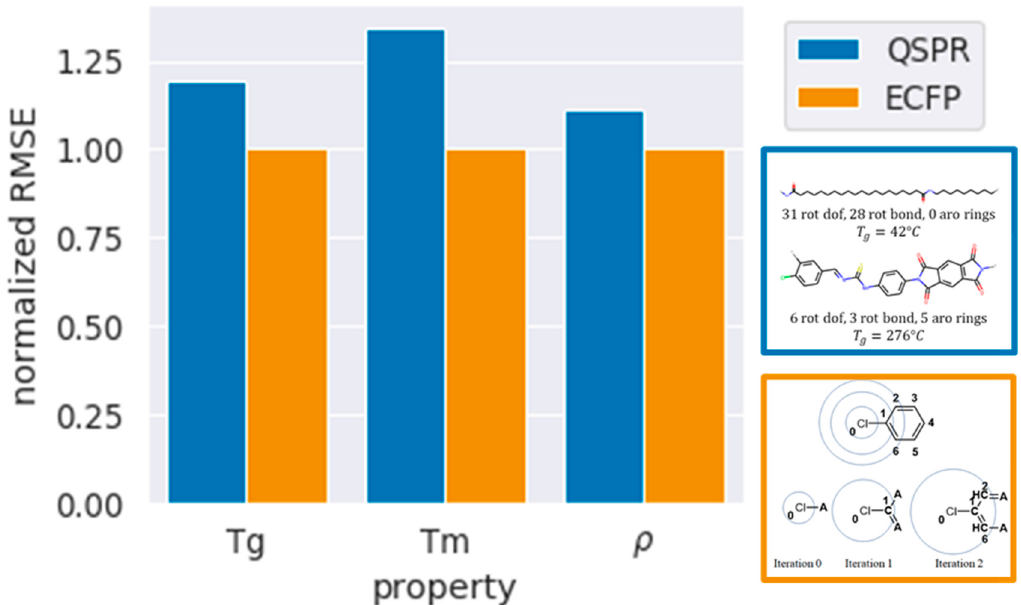
Figure 6. Summary of the best models using each fingerprinting technique represented as normalized RMSE. The normalization is performed relative to the most accurate ECFP model. Table 3. The model fit data and the most important features for each of the properties using interpretable QSPR fingerprints. The most important features are based on normalized feature sets.